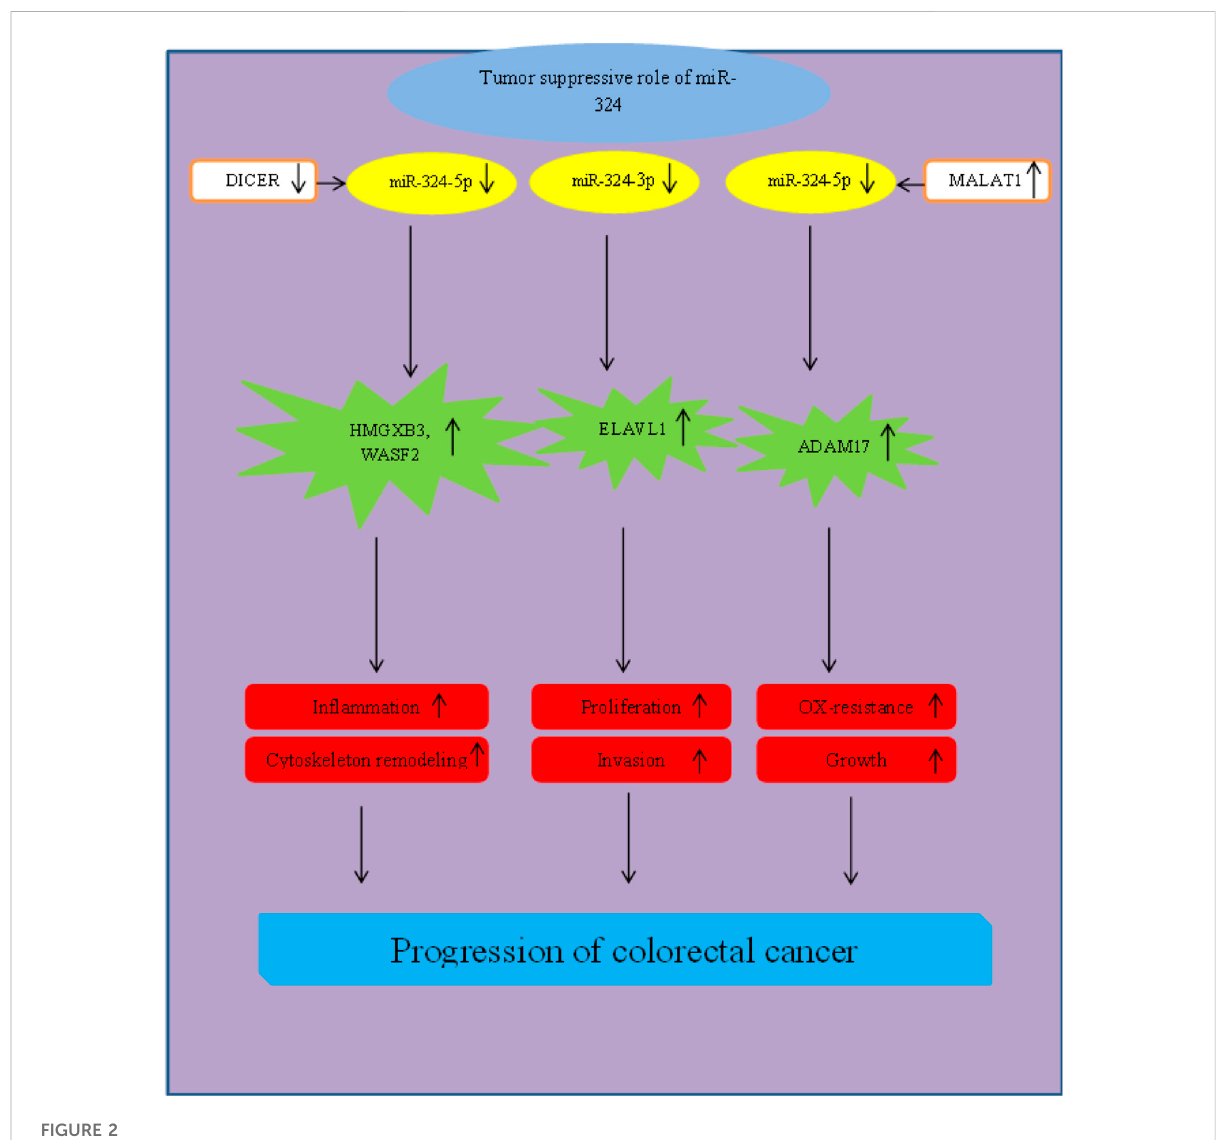
FIGURE 2 Role of miR-324 in progression of colorectal